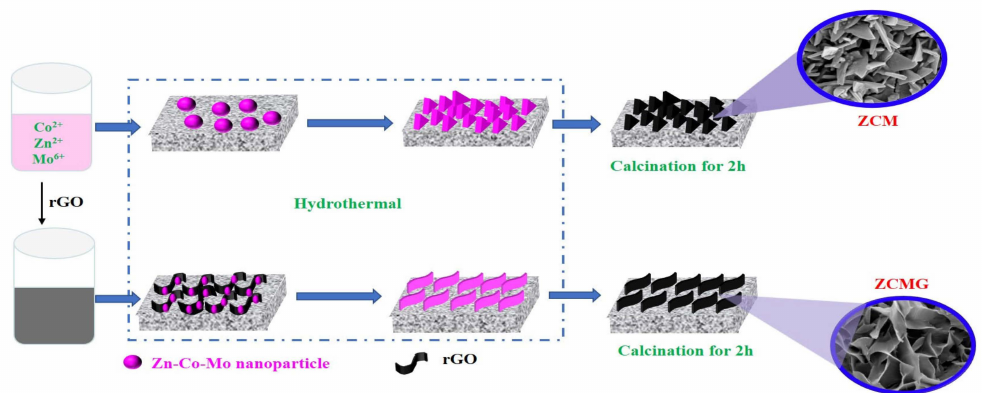
Figure 1. Synthesis route of ZCMG and ZCM nanosheets on